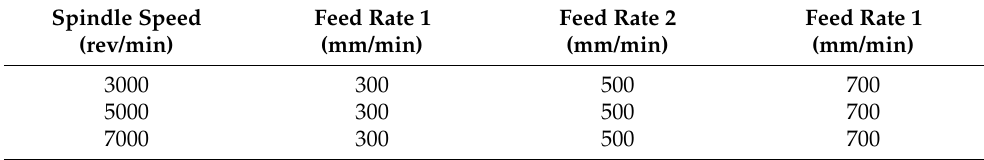
Table 1. Experimental machining parameters